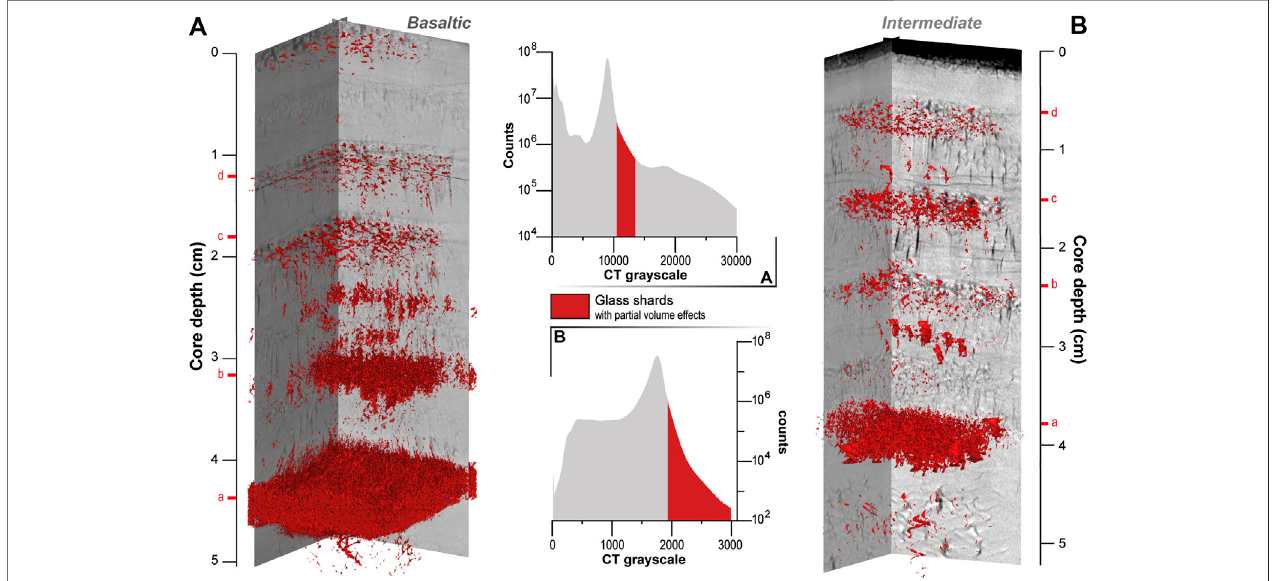
FIGURE 3 | Interlocking 2-D CT orthoslices and 3-D representations of horizons of basaltic (A) and intermediate (B) glass composition in the synthetic ice cores scannedforthisstudy.Thehistogramsshowthegrayscalevaluedistributionofeachscaningray,whilehighlightingtherangeoftephrainred.Thepositionofeachadded tephra horizon is highlighted with a red dash (and letter; Figure 1